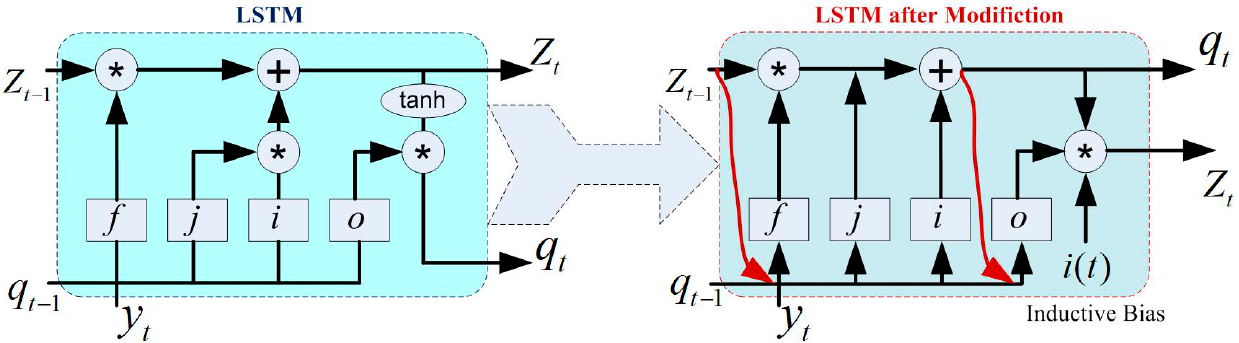
Figure 9. The modified LSTM along with standard LSTM architecture representation [25].